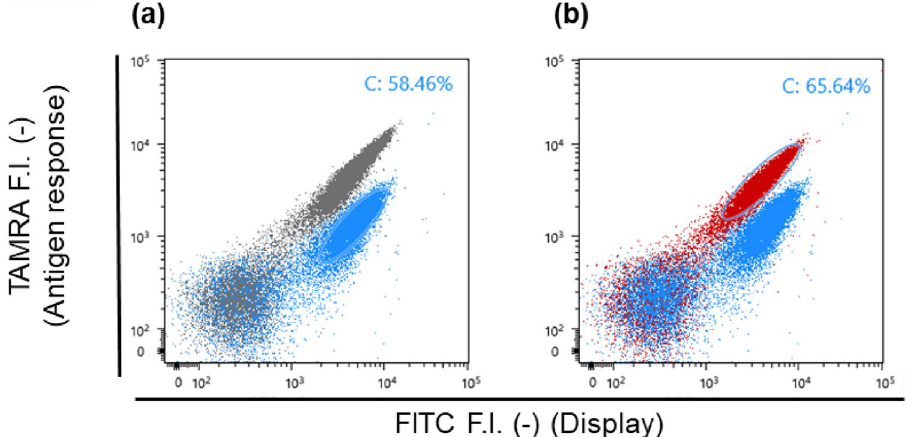
Figure 3. Flow cytometric analysis for yeast cells displaying E4-MTX VHH labeled with FITC-K4-TAMRA. ( a ) Analysis of quenching. ( b ) Analysis of de-quenching. Grey dots represent the yeast cell displaying E4 peptide. Blue dots represent the yeast cell displaying MTX VHH in the absence of MTX. Red dots represent the yeast cell displaying MTX VHH in the presence of 1 µM